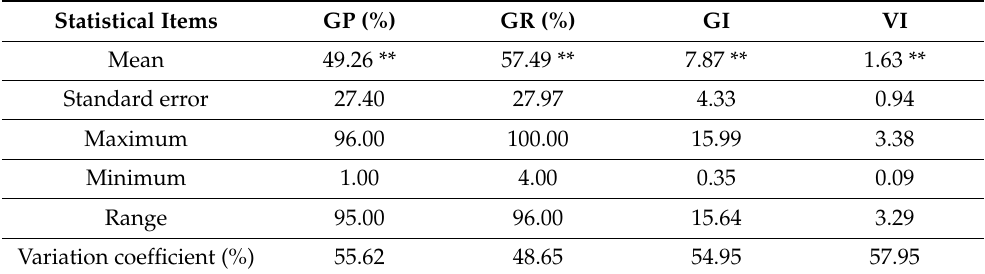
Table 1. Variation in seed vigor indexes of 131 soybean strains included in the regional test in Huanghuaihai, China, in